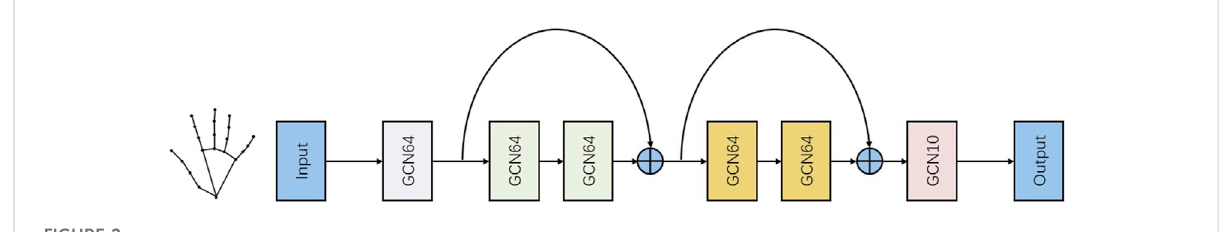
FIGURE 2 Illustration of our graph convolutional network architecture. The input is the coordinates of 21 hand joints. The two side paths that both bypass two 64-channel GCN, bring residual mechanism to our architecture.